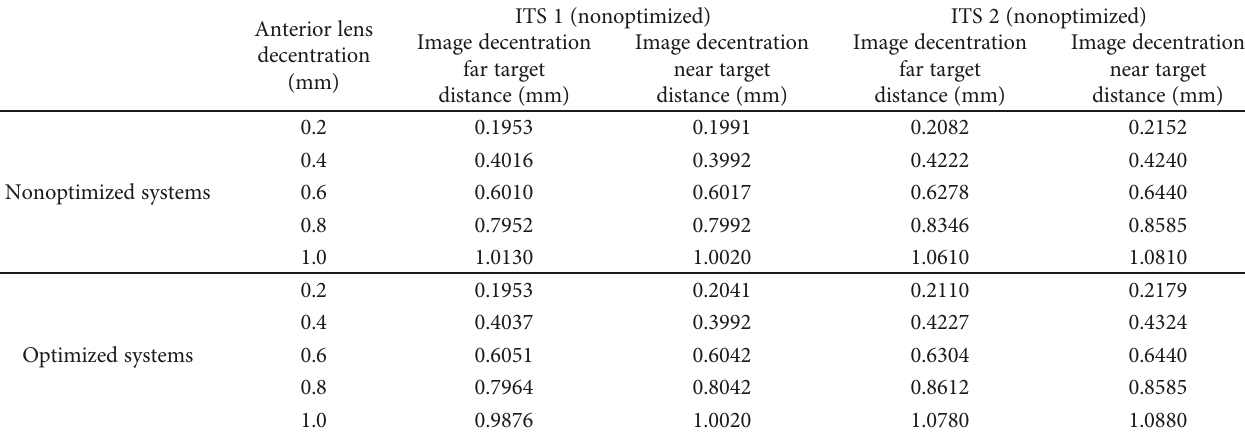
Table 3: Image decentration for both optimized and nonoptimized ITS over anterior lens